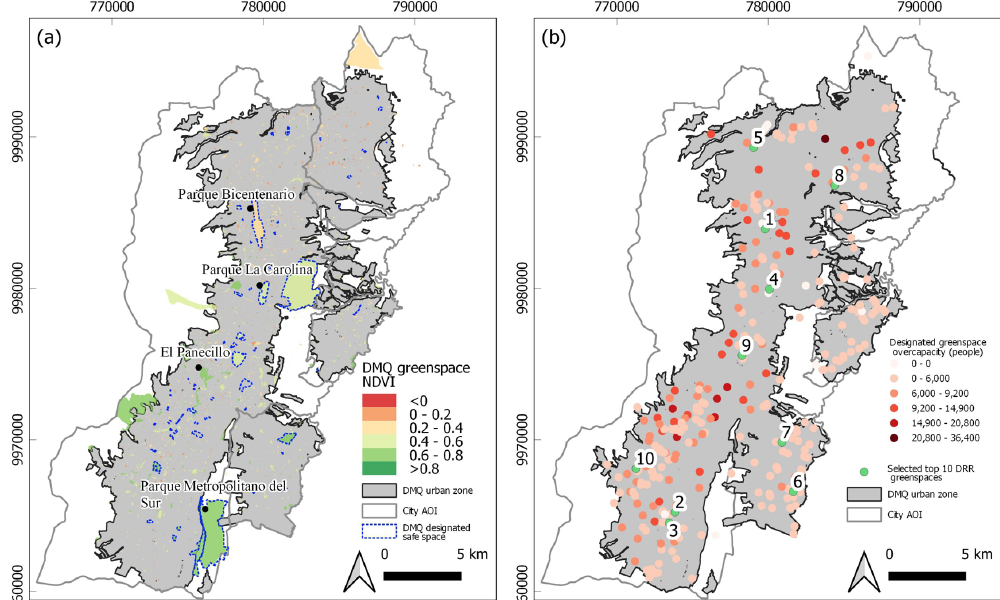
Figure 10. (a) Designated green areas and safe spaces (dashed blue polygons) from Open Government data and their mean NDVI extracted using Pleiades satellite data. (b) Overcapacity of DRR greenspace in currently designated greenspaces or safe spaces. Green markers show the top 10 DRR greenspaces based on a maximum capacitated coverage model.